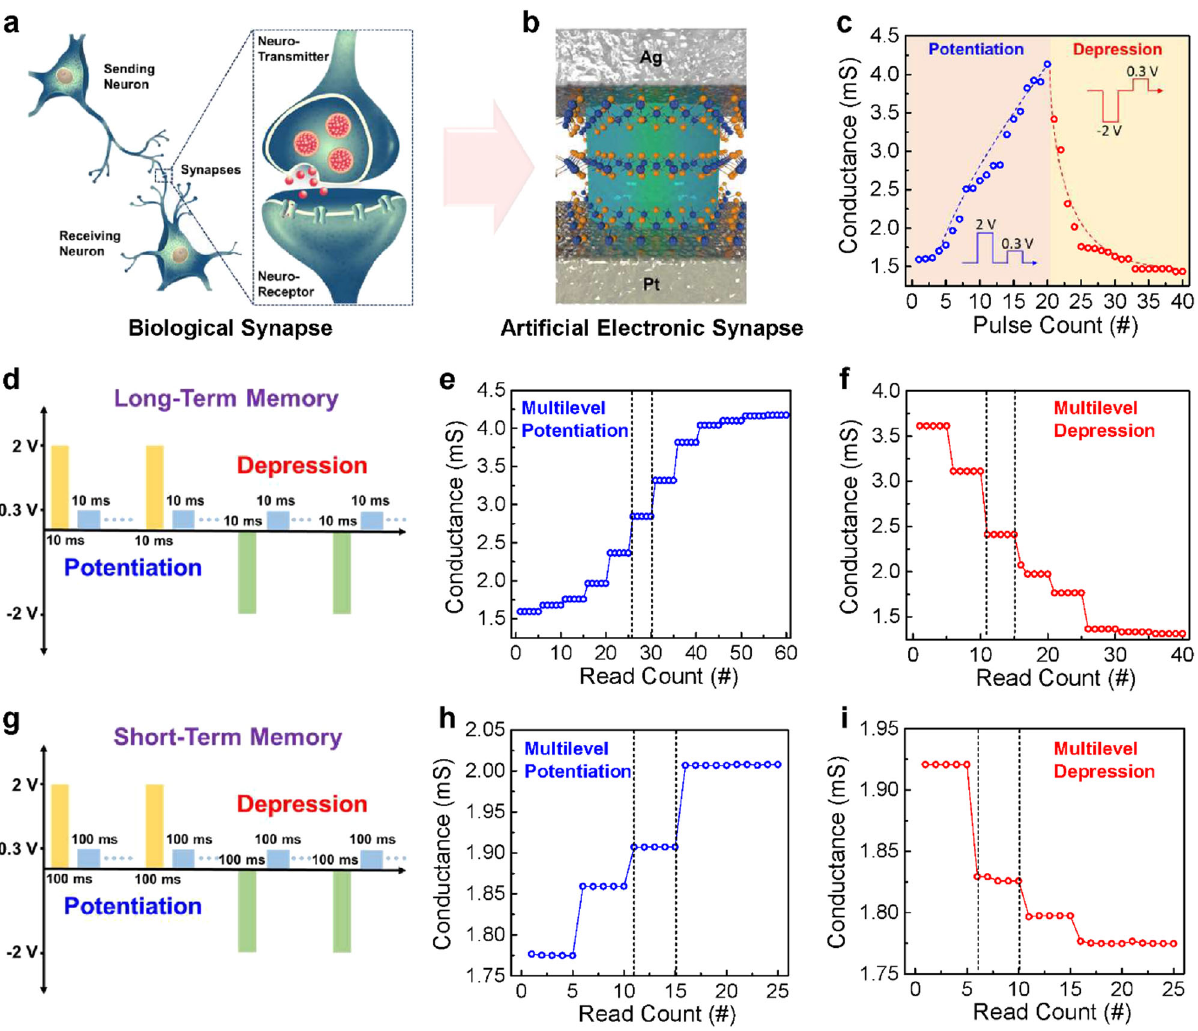
Fig. 3 Synaptic measurements of the proposed MoS 2 memristor. a Schematic description of biological synapse with a representation of neurotransmitter and neuroreceptor. b Schematic layout of the presented prototype of the arti fi cial electronic synapse. c Electric potentiation and depression of the MoS 2 based memristor device by applying a single consecutive pulse at a read voltage of 0.3 V with a set voltage of 2 V (potentiation) and a reset voltage of − 2 V (depression), with a width of 10 ms. d Schematic representation of long-term memory measurement settings. e , f Multilevel long-term potentiation and depression of proposed arti fi cial electronic synaptic device by applying fi ve consecutive pulses at a read voltage of (0.3 V) with a set voltage of 2 V (multilevel potentiation) and a reset voltage of − 2 V (multilevel depression), with a width of 10 ms, respectively. g Setting representation of multilevel short-term depression of the arti fi cial electronic synaptic device. h , i Multilevel short-term potentiation and depression by applying fi ve consecutive pulses of 0.3 V read voltage with set (2 V) and reset ( − 2 V) voltages, with a width of 100 ms,